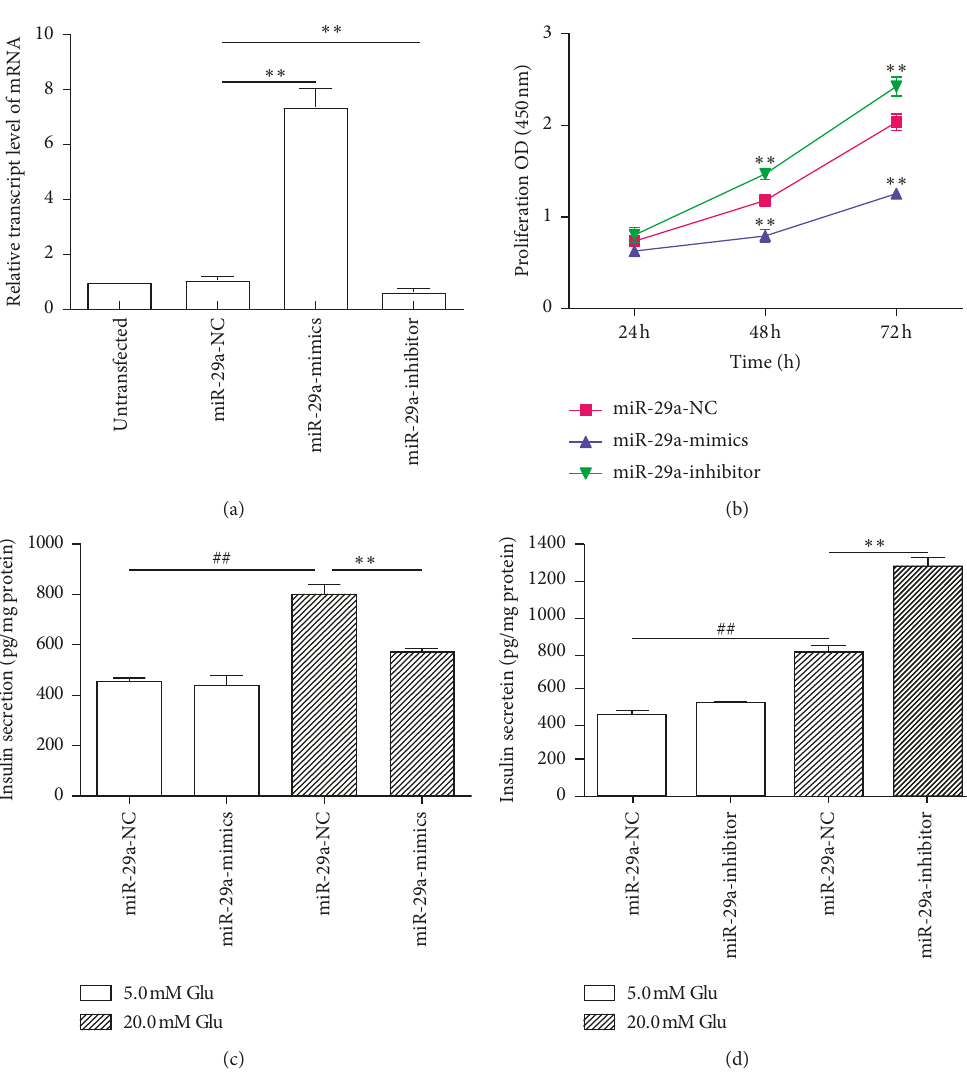
Figure 1: Effects of miR-29a on MIN6 cells. (a) Effects of miR-29a mimic and inhibitor on miR-29a mRNA. RT-PCR to detect miR-29a mRNA expression after transient transfection with miR-29a mimic and inhibitor ( n � 3). ∗∗ P < 0 . 01, compared with miR-29a NC group, as assessed by paired Student’s t -test. (b) Effects of miR-29a on MIN6 cell proliferation. CCK assay to detect proliferation after transfection with miR-29a mimic and inhibitor ( n � 3). ∗∗ P < 0 . 01, compared with miR-29a NC group, as assessed by one-way ANOVA, followed by Fisher’s least significant difference test. (c and d) Effects of miR-29a on insulin secretion by MIN6 cells. ELISA to detect insulin secretion levels in MIN6 cells after transient transfection with miR-29a mimic and inhibitor under basal-glucose (5.0mM) and high-glucose (20.0 mM) stimulation ( n � 3). ## P < 0 . 01, compared with 5.0mM glucose group, and ∗∗ P < 0 . 01, compared with miR-29a-NC group, as assessed by paired Student’s t -test. Data are shown as mean ± SD. NC: negative